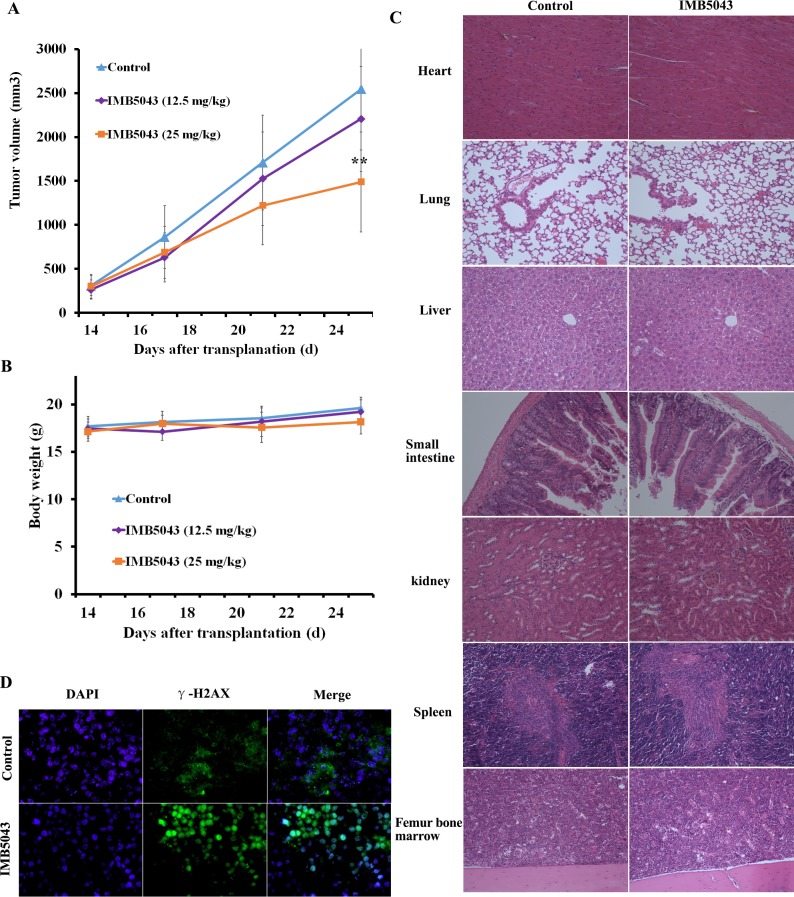
In vivo antitumor activity.(A). Tumor growing curves of human hepatoma cells SMMC7721 xenograft model in athymic mice (n = 6). IMB5043 was given on days 14–18 & 21–24. **P<0.01 (B). Body weight change of SMMC7721 xenograft-bearing mice. (C). Histopathological examination (hematoxylin and eosin stain) of mice treated with IMB5043 (25 mg/kg). No toxicological damage was found in the heart, lung, liver, small intestine, kidney, spleen, and femur bone marrow. (D). γ-H2AX immunofluorescence staining of frozen tumor sections from control groups and 25 mg/kg IMB5043 group. n = 6 mice per group.